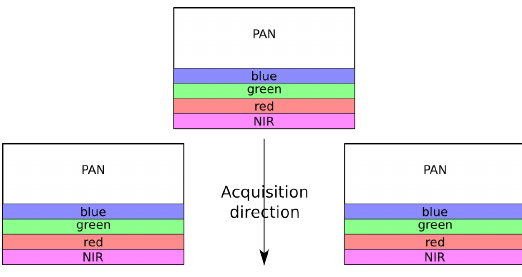
Figure 11: Focal plane assembly SkyBox, three frame cameras splitted in a PAN and four multispectral bands Fig. 12 shows an example of a plane crossing the acquisition path of SkyBox. The image is a orthorectified composite of the 1-m- PAN-band (in gray) and overlayed the four 2.5-m-multispectral bands (blue, green, red and NIR shown as purple). As can easily be seen in the PAN band the image consists of about 20 single frame camera images which are merged to one master image in the SkyBox level-1B-preprocessing. The same procedure is ap- plied to the four half-resolution multispectral bands. But with the lower resolution no single planes will be visible here any more but only one blurred combined image. The distances of the centres of the plane images correlate with the FPA as shown in fig. 11.